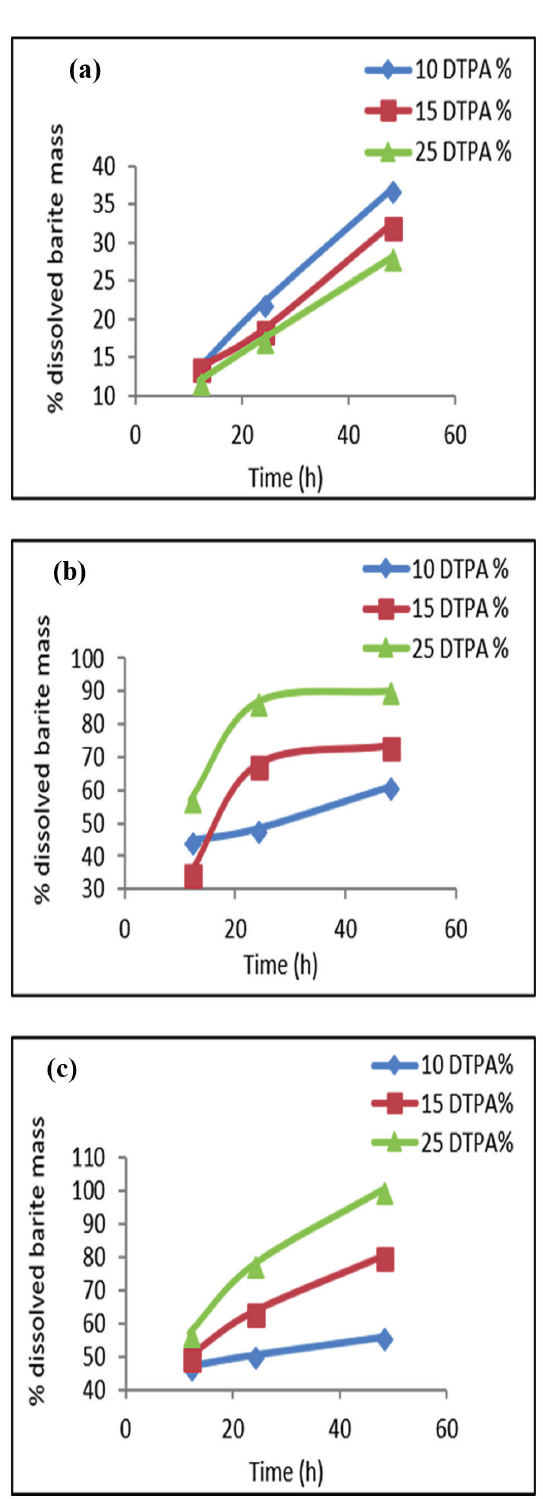
Figure 2 - Dissolved barite mass (%) versus residence time (h) for static test at 23 °C ( a ), 50 °C ( b ) and 80 °C ( c ) for 10%, 15% and 25% DTPA in solution,